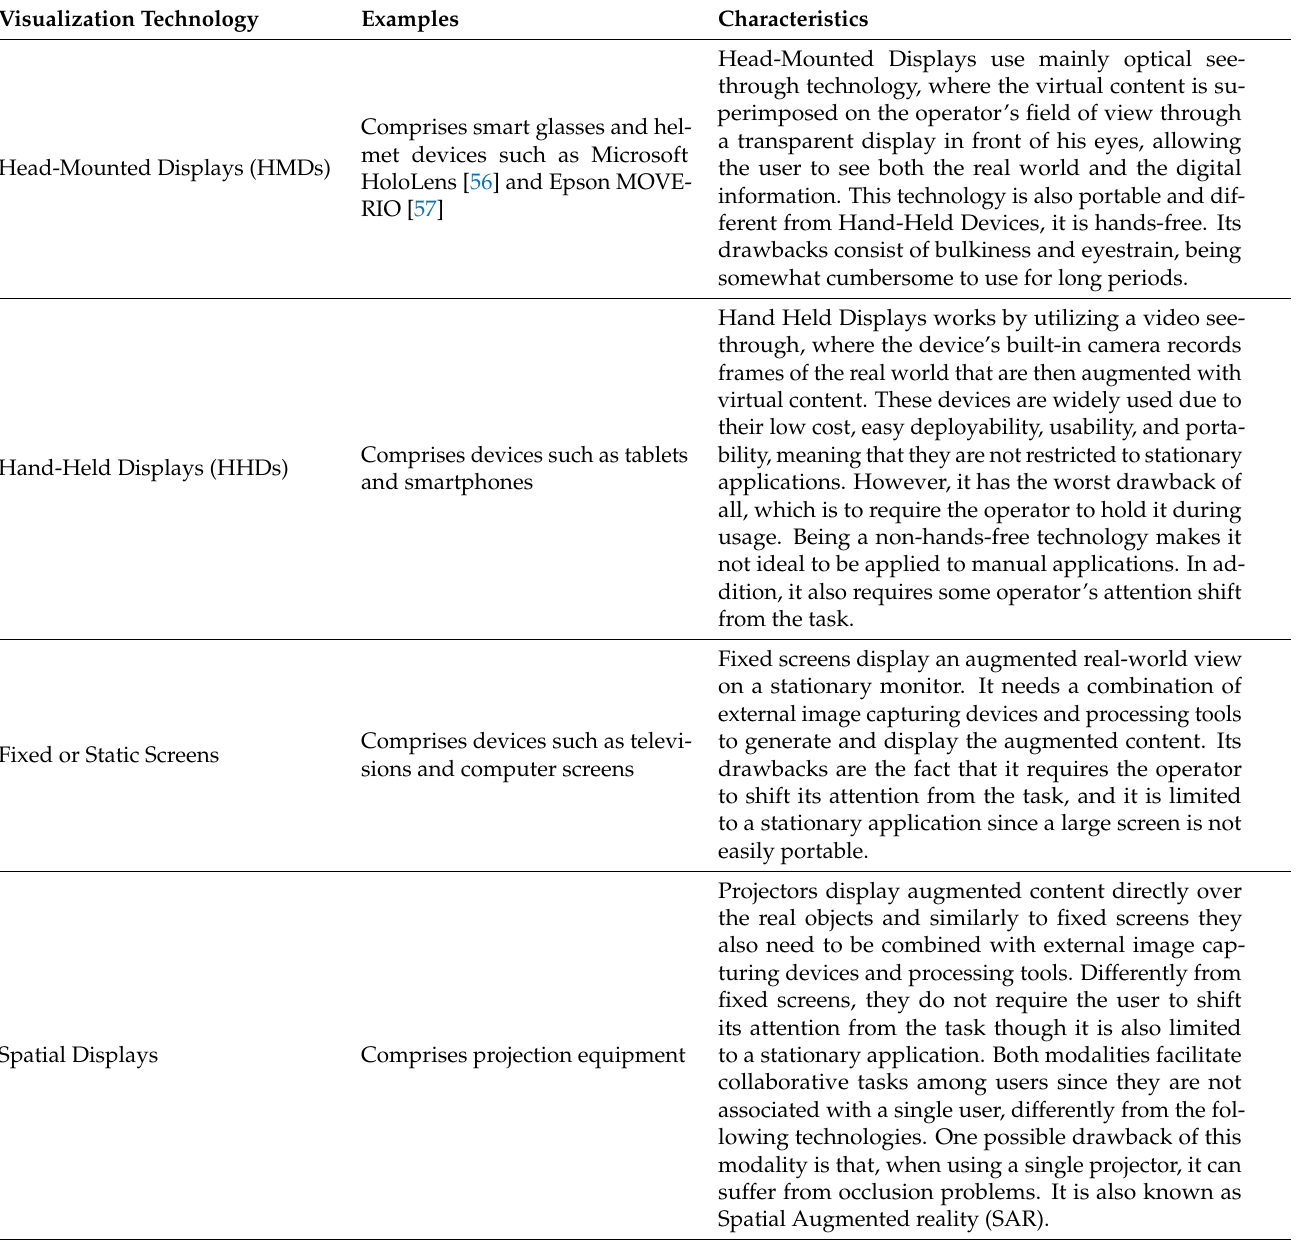
Table 1. AR visualization technologies and its